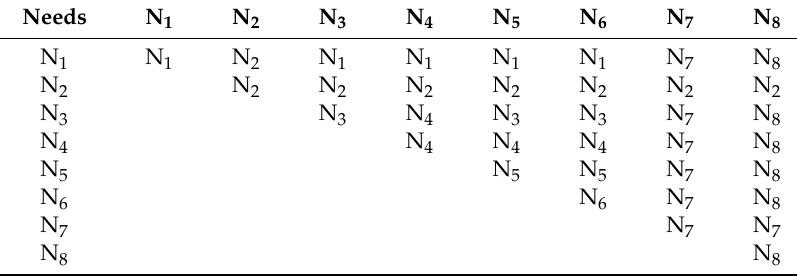
Table 4. Comparisons for the importance of needs for a wheelchair.